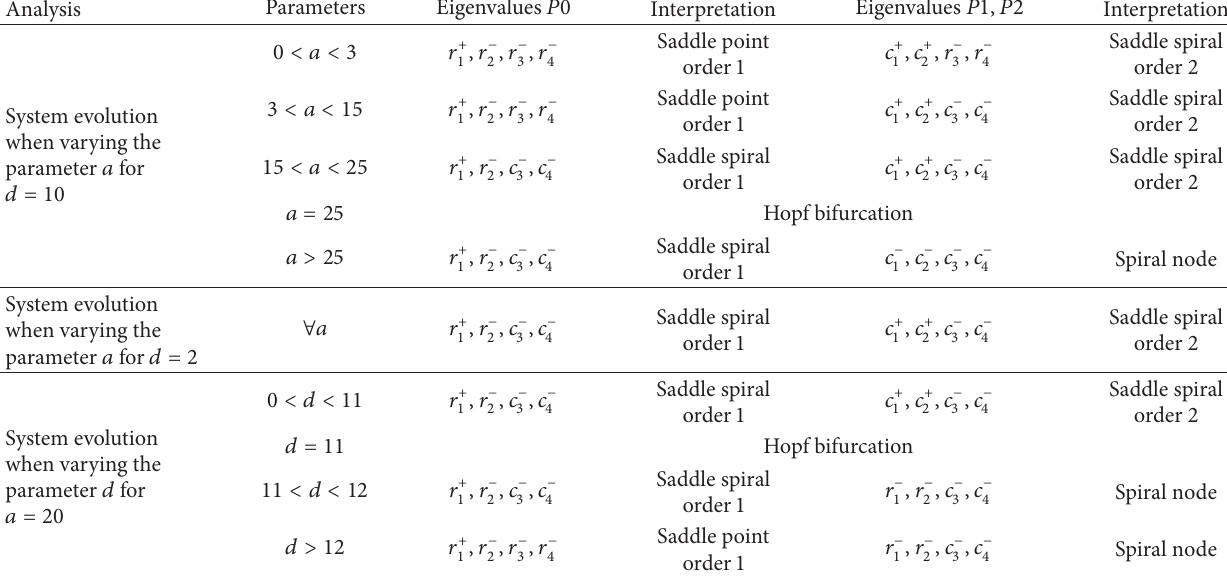
Table 1: Local stability